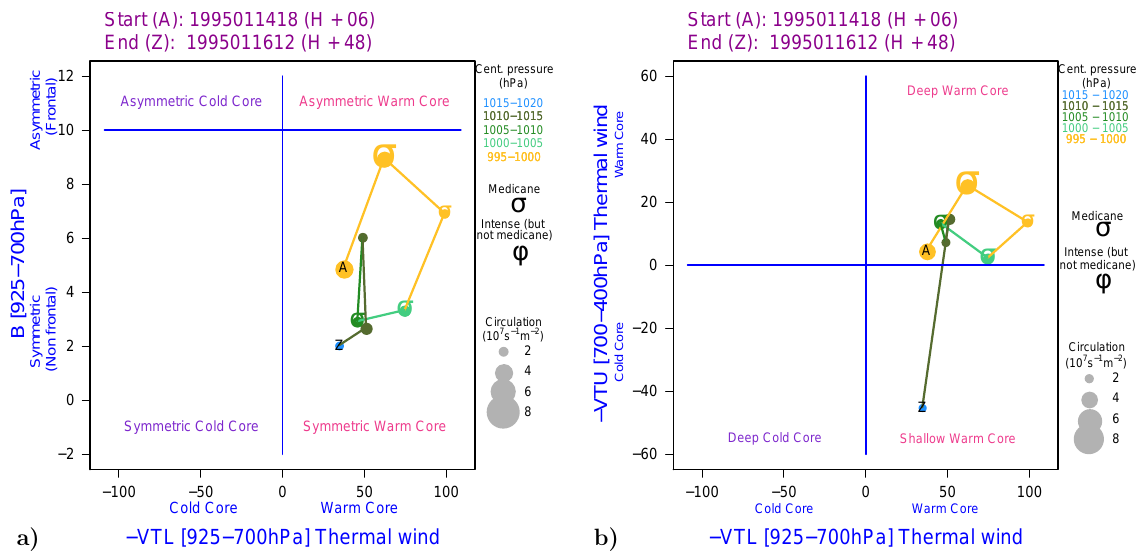
Fig. 7. Cyclone phase diagrams I (a) and II (b) , as Fig. 3, for January 1995 medicane.